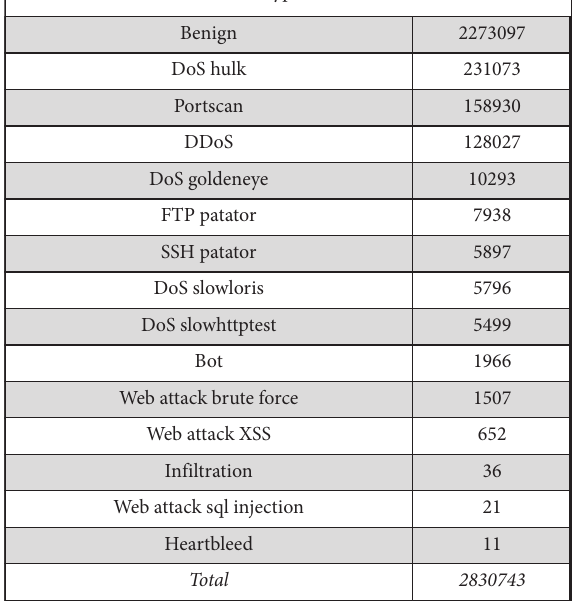
Figure 3: Dataset